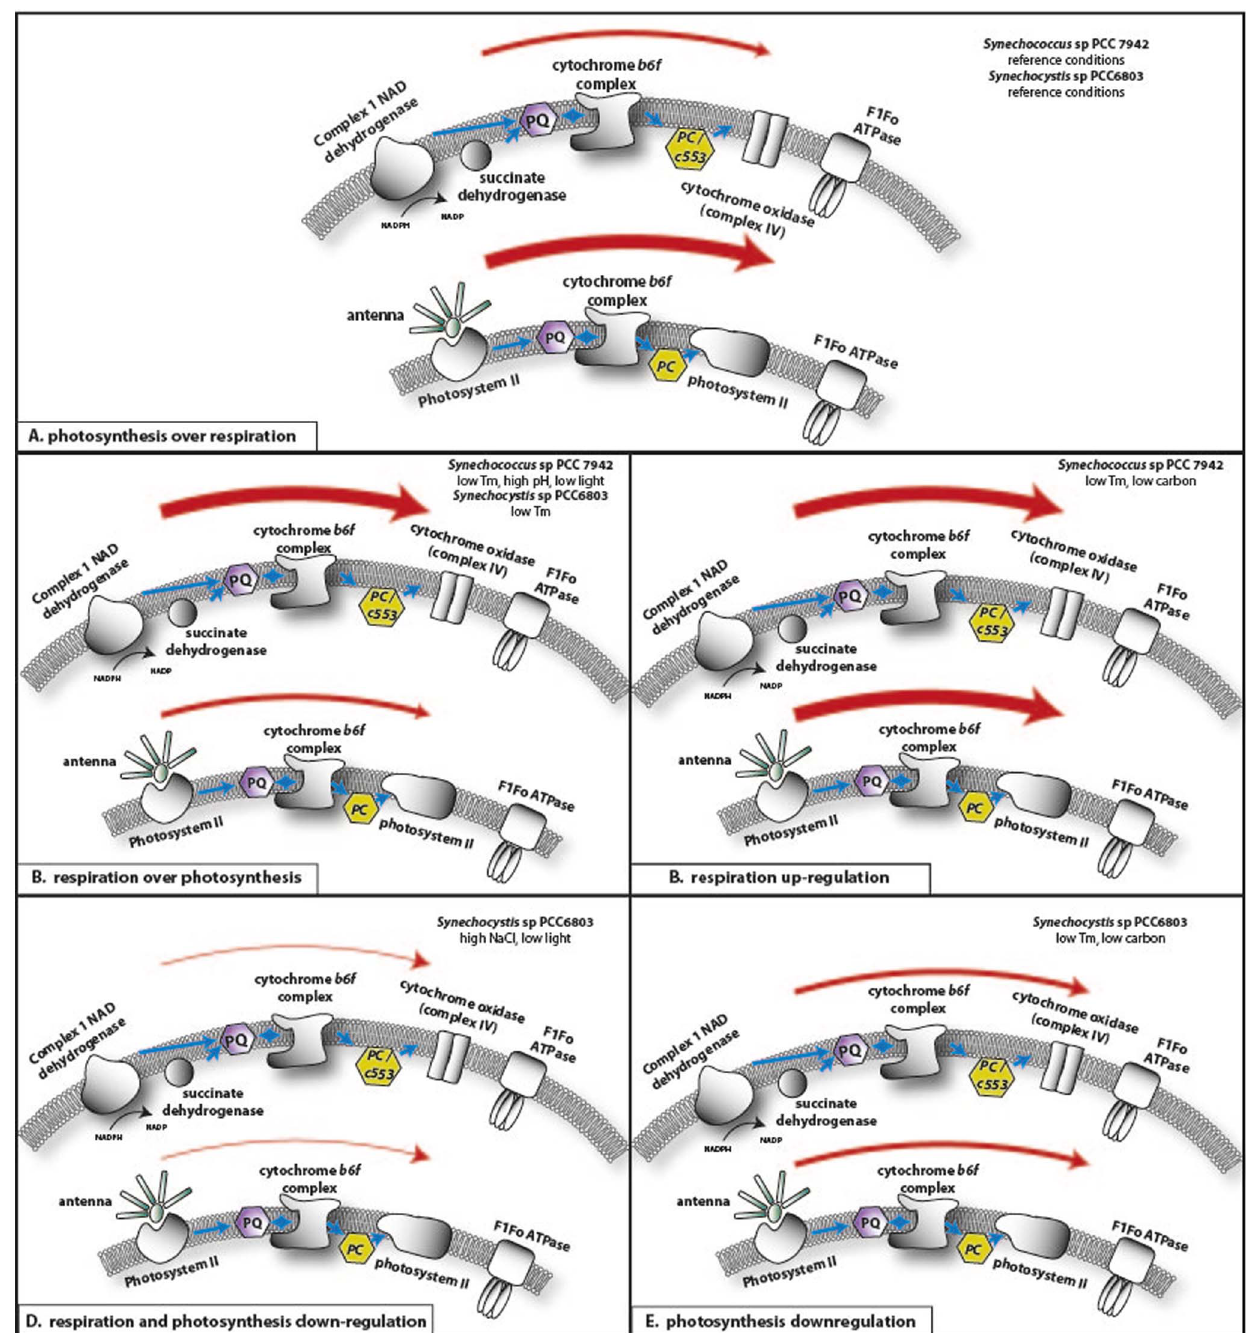
Figure 3. Model: How the relative expression of components of the electron transport chains of photosynthesis and respiration may affect the energy flow at specified time points of stress acclimation. The thickness of the respective arrows represents the suggested intensity of the energy flow. The conditions that apply to the panel are shown in the upper right of the panel. Panel A. Reference conditions, in the presence of light the photosynthetic electron transport chain has a higher capacity of electron flow than the respiratory chain. Panel B. Conditions where photosynthetic genes are upregulated and respiratory ones are downregulated ( Synechoccus : alkaline pH (1-h & 24-h), low light (1-h & 24-h), low temperature (24-h), and Synechocystis : low temperature (24-h)). Panel C. Conditions where respiratory genes are upregulated ( Synechococcu s: low temperature (24-h) and carbon limitation (1-h)). Panel D. Conditions where photosynthetic and respiratory genes are both downregulated ( Synechocystis : low light (1-h & 24-h), elevated salinity (1-h)). Panel E. Conditions where photosynthetic genes are downregulated ( Synechocystis : low temperature (1-h), and carbon limitation (24-h)). For simplicity, the two electron transport chains are represented in two different membrane sections, even though respiration is met in the cytoplasmic and both respiration and photosynthesis are intertwined in the thylakoid membrane. The intersection of the two pathways in the thylakoids is more apparent in Synechocystis than Synechococcus , where those two processes are more separated between the cytoplasmic and the thylakoid membrane. This representation only serves the portrayal of the transcriptional changes and their putative affect on energy flow and not the actual distribution of the two chains between the thylakoid and the cytoplasmic membrane. Abbreviations: Temperature (Tm). doi:10.1371/journal.pone.0109738.g003 PLOS ONE |